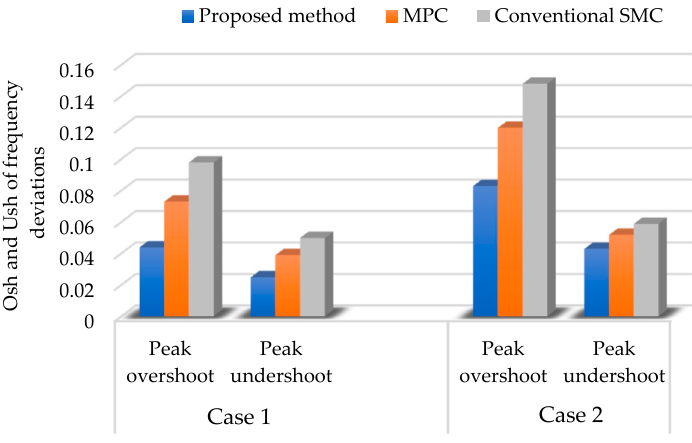
Figure 9. Peak overshoot and undershoot of frequency deviation using various control strategies.